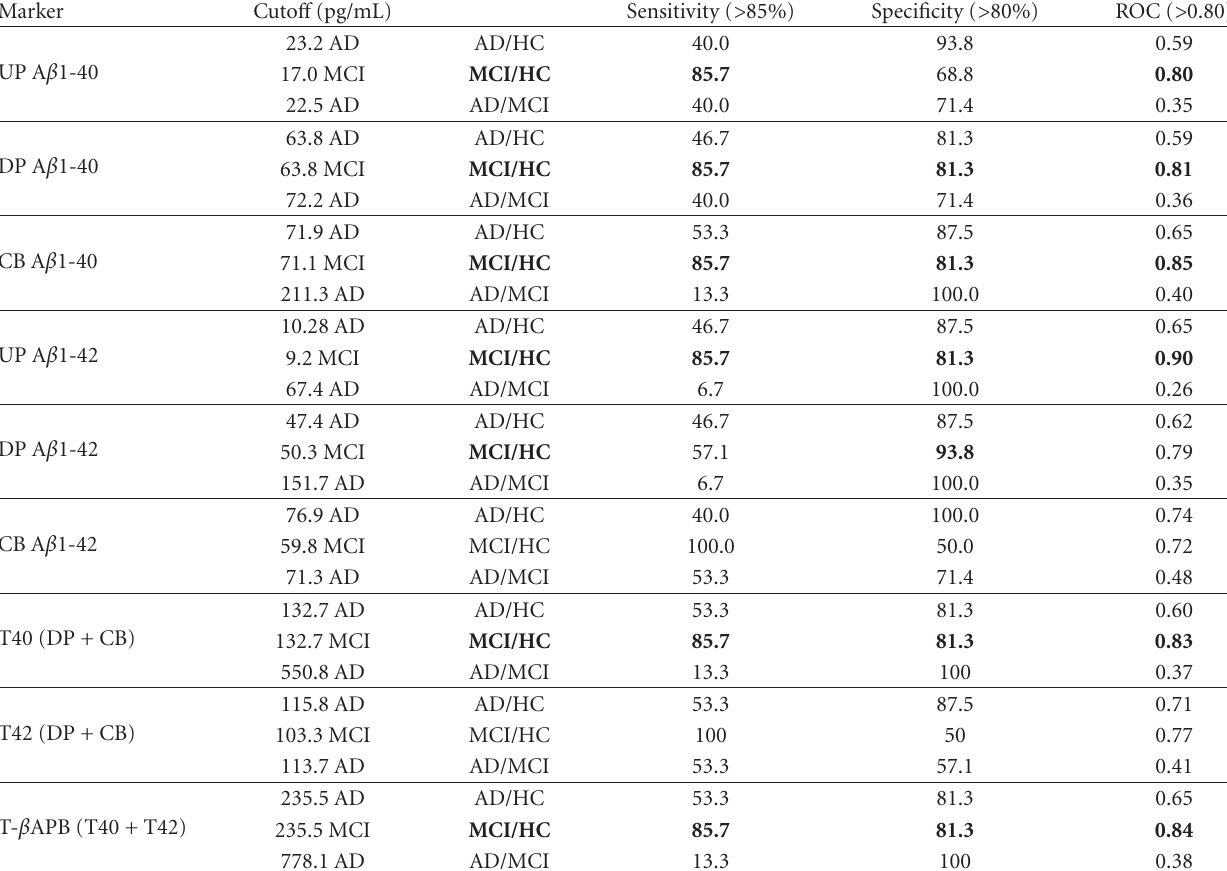
Table 4: Diagnostic features of the direct and calculated markers of the β